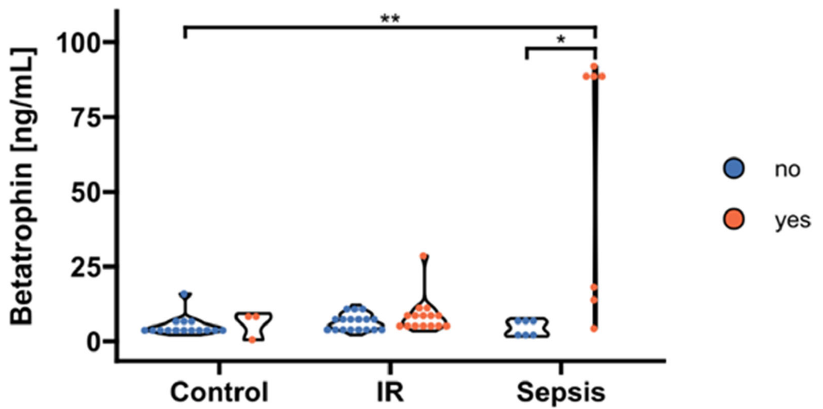
Figure 4. Stratification of circulating betatrophin/ANGPTL8 according to hypertriacylglyceridemia. Levels of circulating betatrophin/ANGPTL8 were significantly increased exclusively in septic patients with concurrent hypertriacylglyceridemia > 1.7 mmol/l (“yes”, n = 7) compared to septic subjects and controls with absent dyslipidemia (“no”, n = 6 and n = 15, respectively; p = 0.017 and p = 0.0015 after post hoc correction, overall significance according to Kruskal–Wallis p = 0.0025). No significant effects became apparent in the insulin-resistance group ( p > 0.05; “yes”, n = 21; “no”, n = 11). IR, insulin resistance. * p < 0.05, ** p < 0.01 in Kruskal-Wallis test and post-hoc Dunn correction.